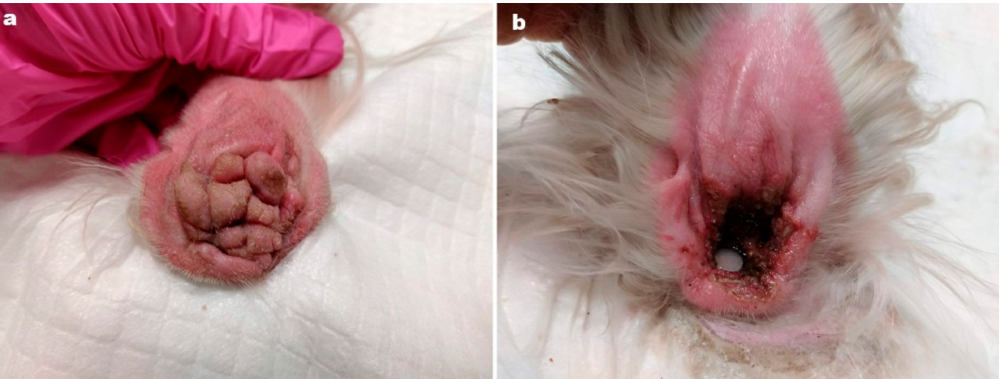
Figure 6. Laser surgery of chronic hyperplastic occlusive otitis, courtesy Dr. Jeylan Aslan, Dermatol- ogy for Animals, 263 Appleby Road, Stafford Heights, QLD 4053, Australia [21]. ( a ) Preoperative photo demonstrating occlusive grossly hyperplastic, ( b ) immediate postoperative picture showing removal of all excess tissue, minimal haemorrhage, and patent external ear